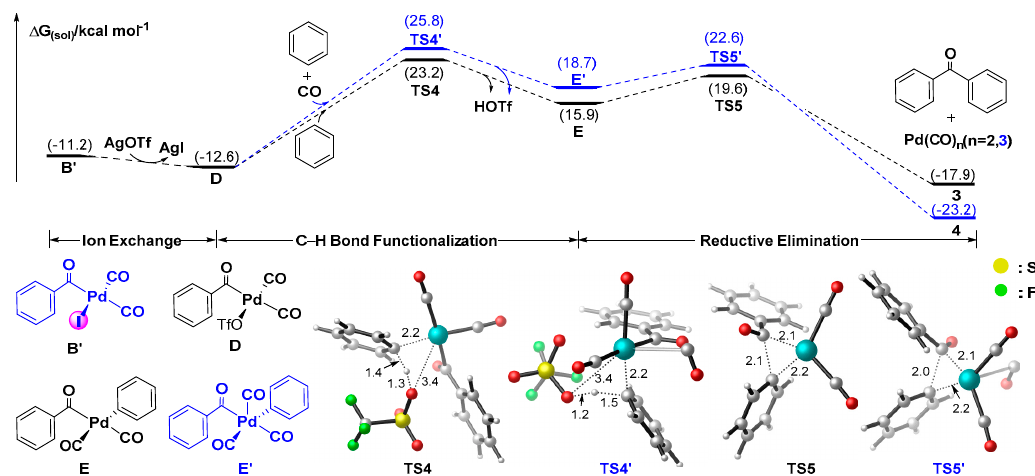
Figure 3. Calculated reaction potential surfaces for the formation of ketones catalyzed by palladium-aroyl intermediate.